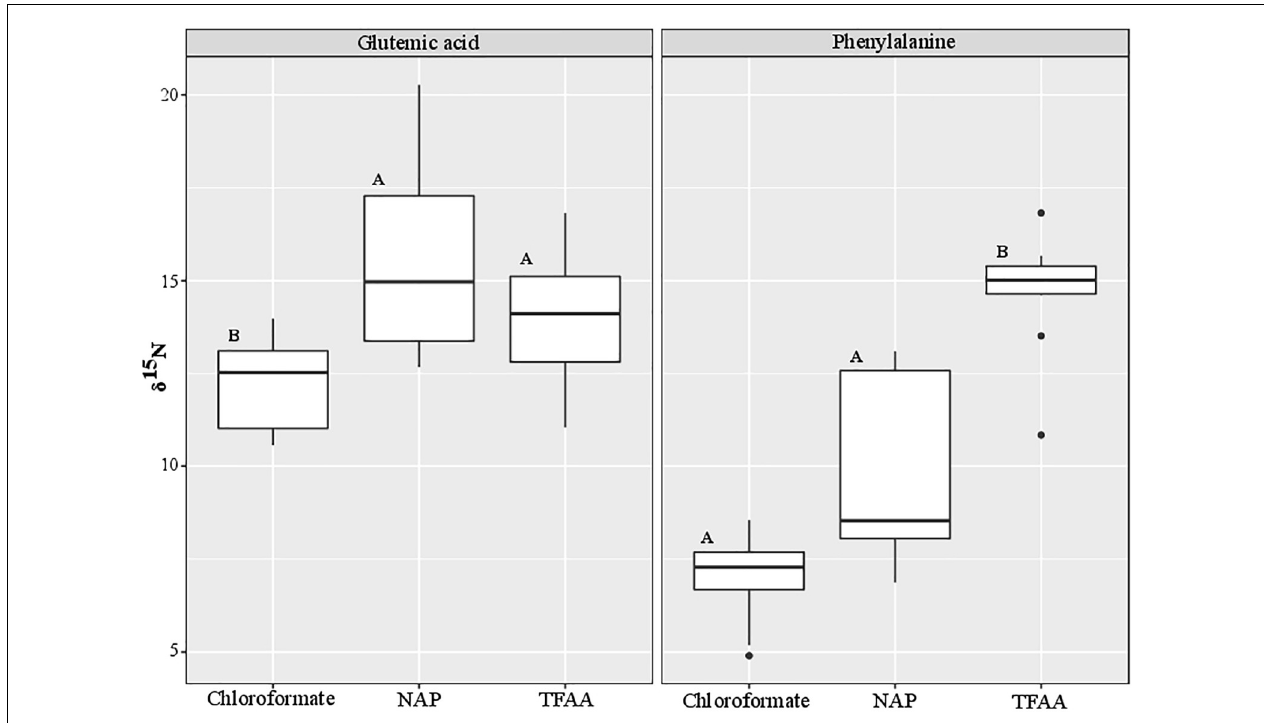
FIGURE 2 | Comparison of the nitrogen isotopic values between different derivatization methods. The black bar in the box marks the median δ 15 N value and the black dots are outlier values. Statistical significance is indicated in bold letters, and p -values are considered for p <